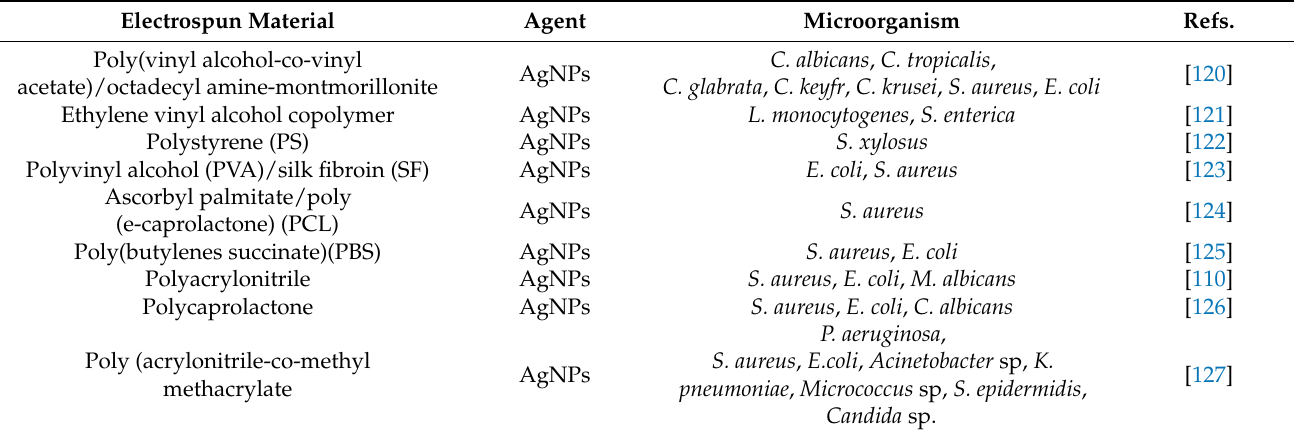
Table 3. Antibacterial electrospun fibers (the selected